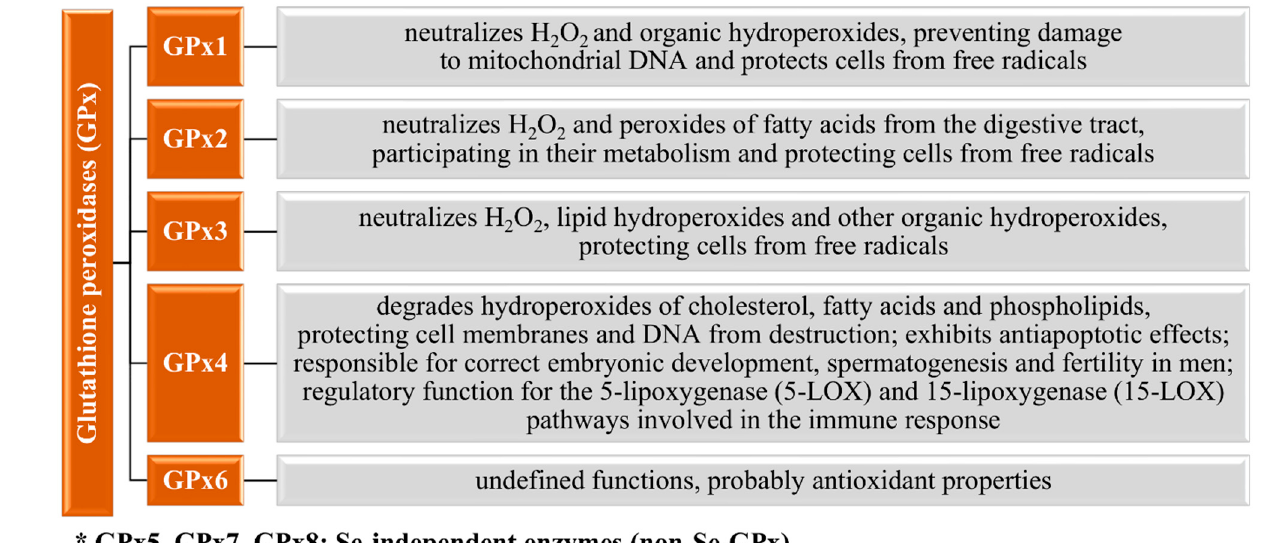
Figure 3. Selenoproteins of the glutathione peroxidases (GPx) family and their functions [85,87–89].